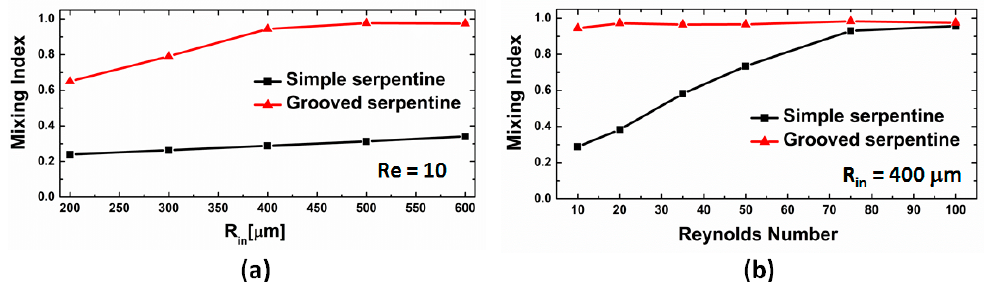
Figure 7. ( a ) Dependence of the mixing index on the radius of curvature R in at Re = 10; ( b ) Dependence of the mixing index on the Reynolds number for the design with R in = 400 µ m.